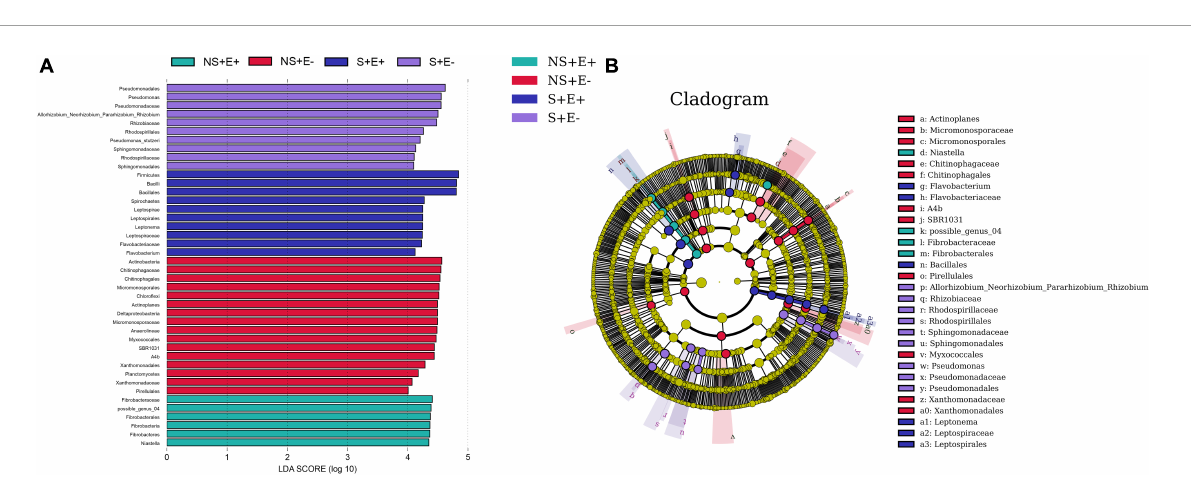
FIGURE9 The taxonomic differences between treatments based on E. ludwigii B30 inoculation and salt stress in bermudagrass. The LEfSe map of bacteria including LDA (A) and Cladogram (B) in bermudagrass roots. LEfSe map is a linear discriminant analysis based on the composition of sample taxonomy according to different grouping conditions. In the four treatments, P < 0.05, LDA > 4 as the standard, communities with significant differences at each classification level are found to be represented by bar chart. Cladogram can intuitively show the difference information of samples at each classification level. “NS + ” represents bermudagrass grown without NaCl condition; “S + ” represents bermudagrass under 250 mM salt conditions. “E + ” represents the infection of Enterobacter ludwigii B30, “E–” represents the absence of E. ludwigii B30.